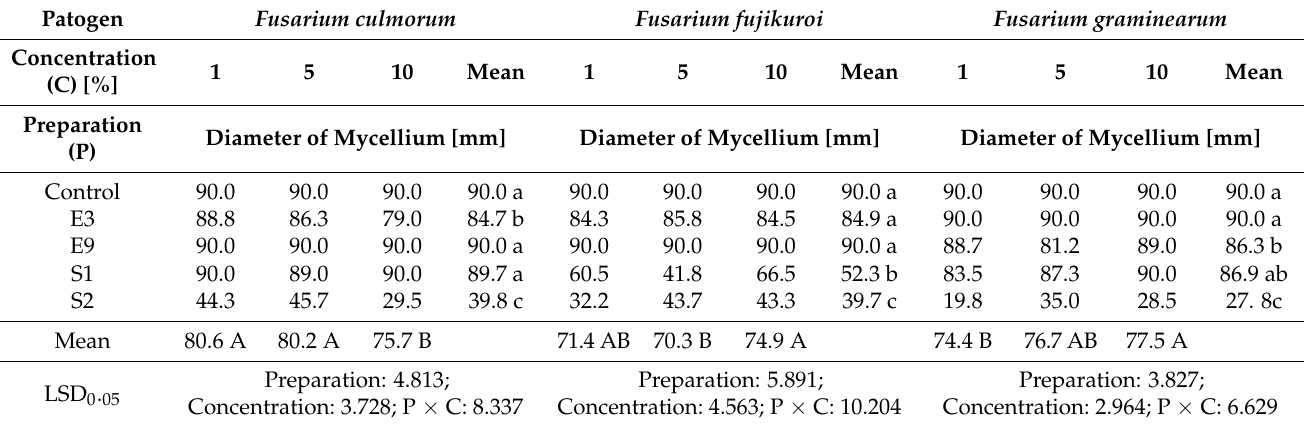
Table 6. Mean values of the mycelium colony diameter for all three